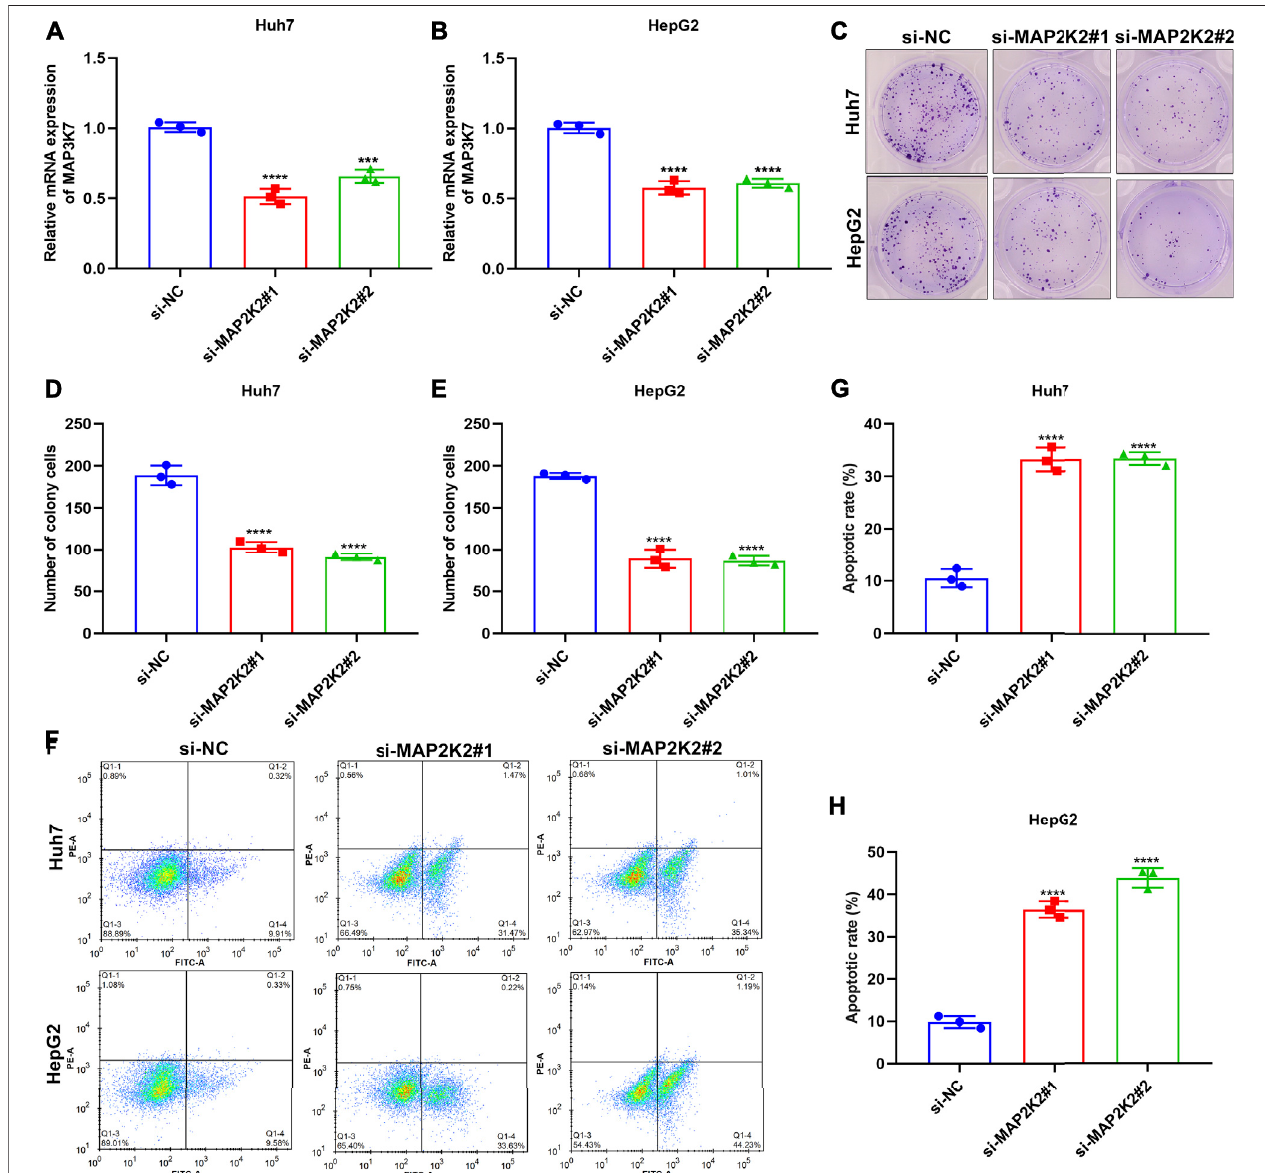
FIGURE9| Silencing MAP2K2weakened colonyformationcapacity and inducedapoptosis ofHCC cells. (A, B) RT-qPCRofthemRNA expression ofMAP2K2 in Huh7 and HeG2 cells with si-MAP2K2 transfection. (C – E) Colony formation assays of the number of colonies of Huh7 and HeG2 cells with si-MAP2K2 transfection. (F – H) Flow cytometry assays of the apoptotic levels of Huh7 and HeG2 cells under transfection with si-MAP2K2. p values were estimated with ANOVA tests. *** p < 0.001; **** p <